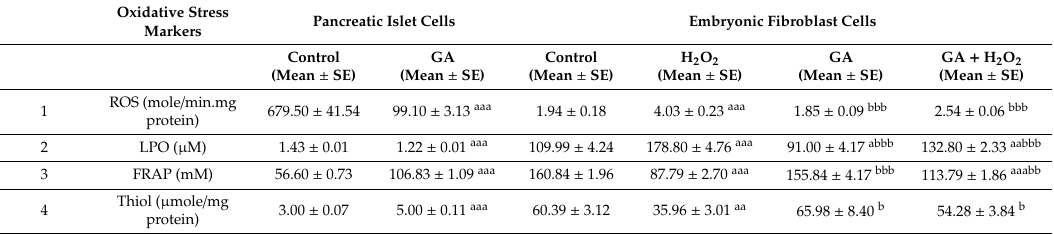
Table 2. E ff ects of gallic acid on oxidative stress markers of rat’s embryonic fibroblast and pancreatic islet cells.